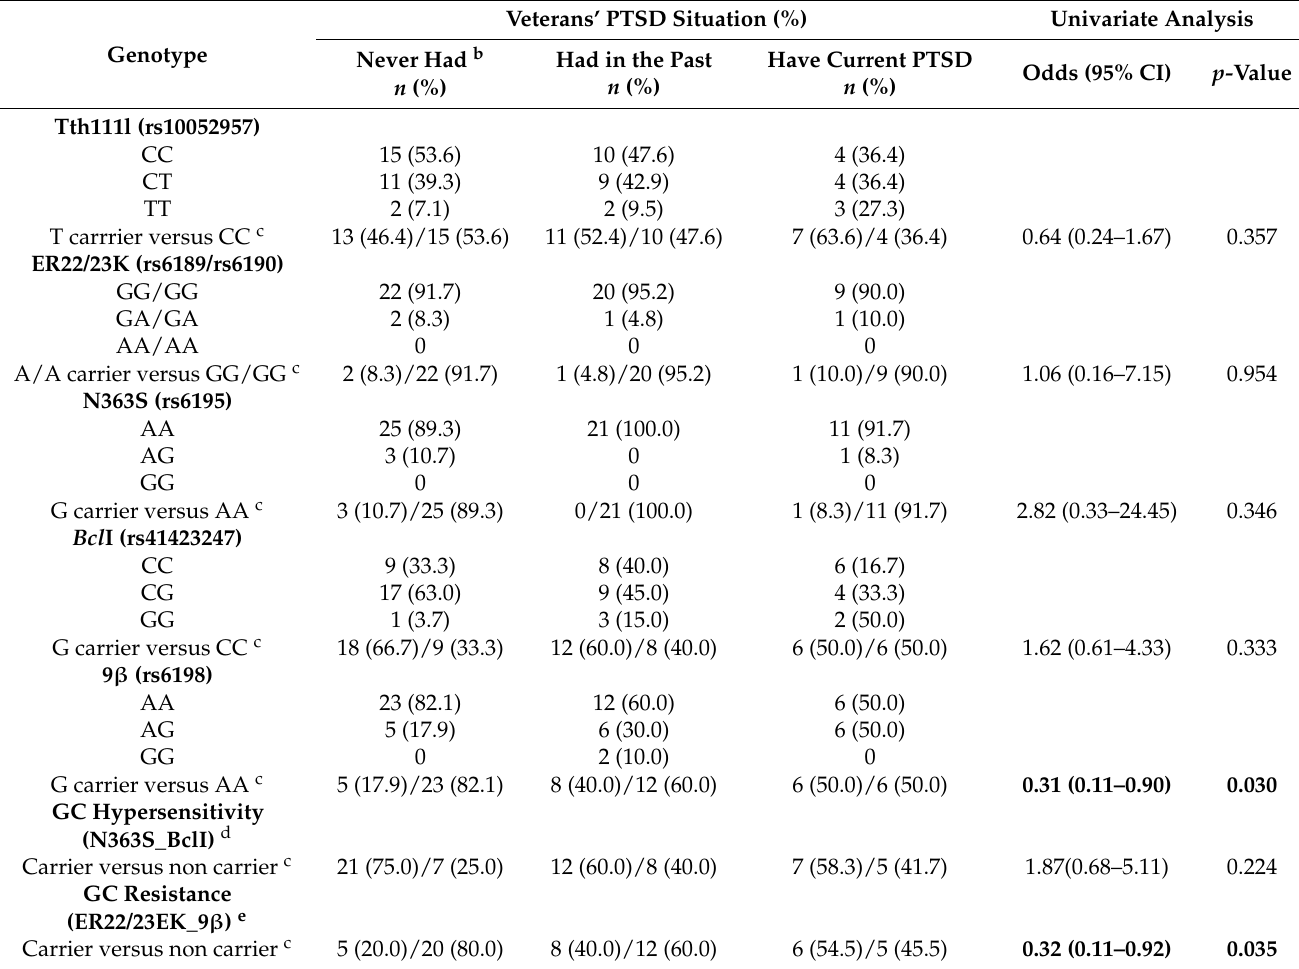
Table 2. Genotypic frequencies and association of the GR gene genetic variants 9 β , Bcl I, N363S, ER22/23EK, and Tth111 I with war veterans’ PTSD classified in three ordered categories a